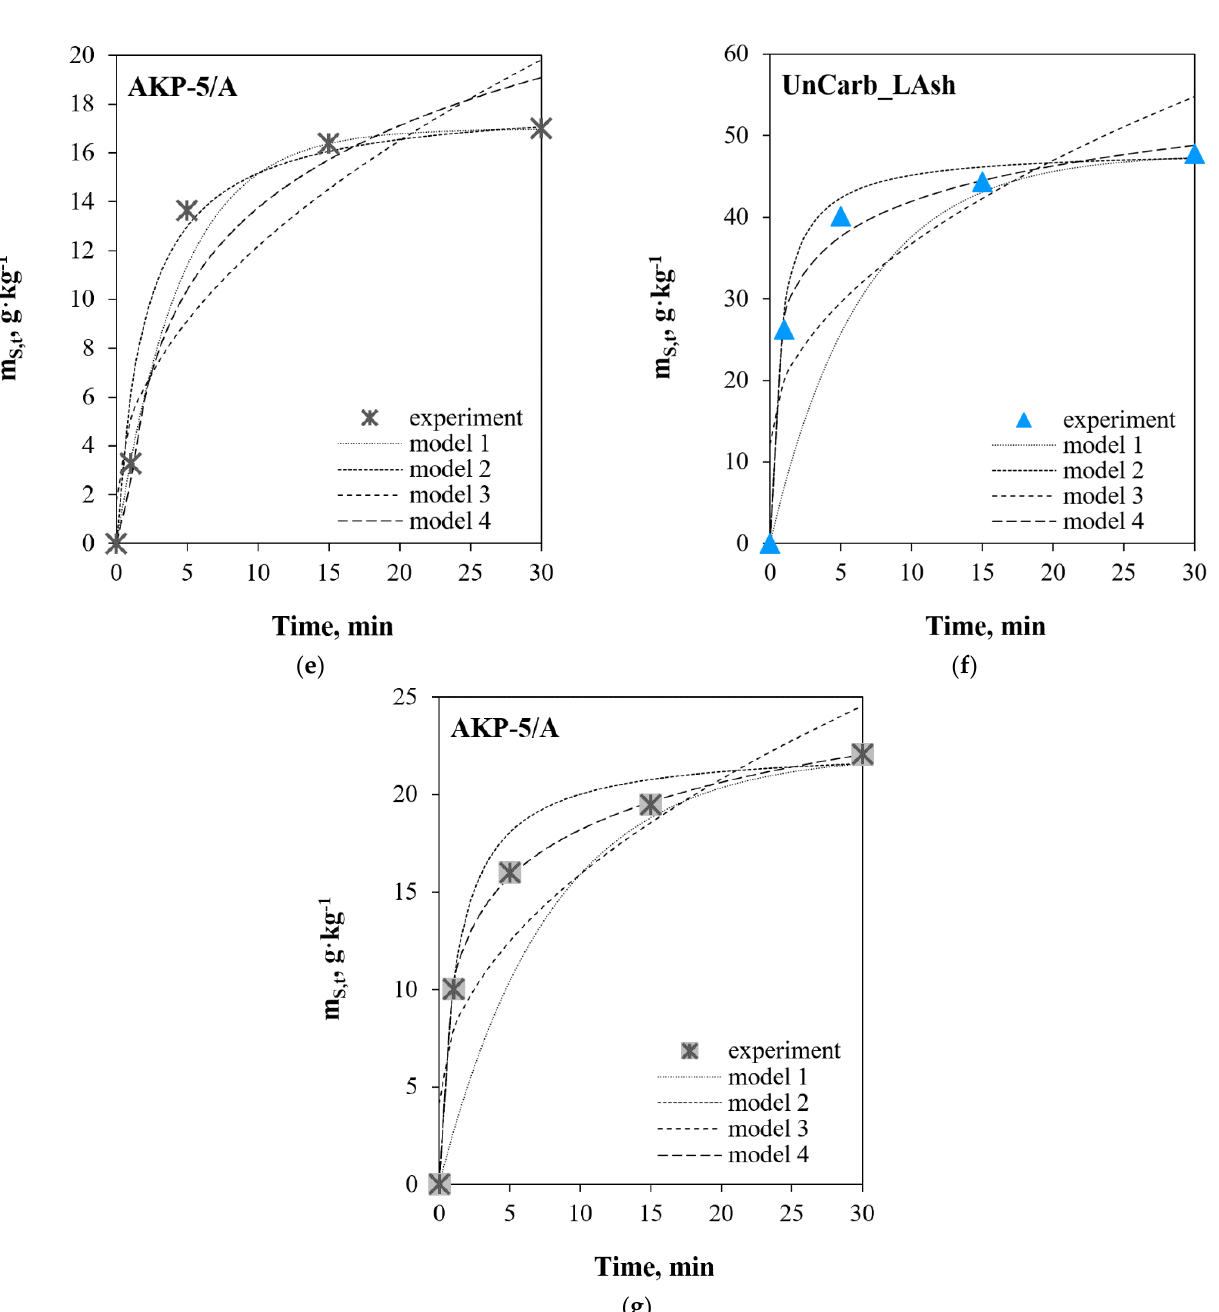
Figure 2. Summary of model and experimental curves for linear regression for the following mix- tures: ( a – e ) SO 2 + Ar, ( f , g ) SO 2 + O 2 + H 2 O (g) + Ar. Table 2. Kinetic parameters determined by the method of linear regression.